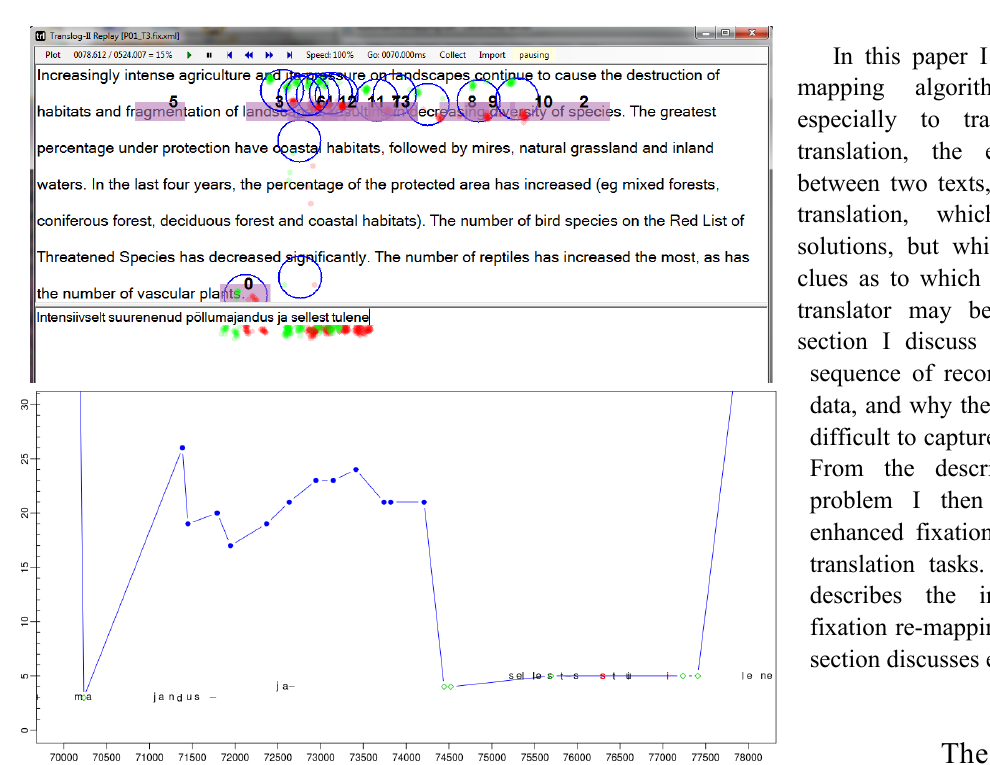
Figure 1 Replay with naïve fixation-to-symbol mapping showing a translation seg- ment of 8 seconds. Top: the Translog-II replay shows the gaze sample points (red and green), the fixations and fixation to word mapping. Bottom: the translation progression graph shows the same segment of time with fixations on the source text (blue) fixations on the target text (green) and